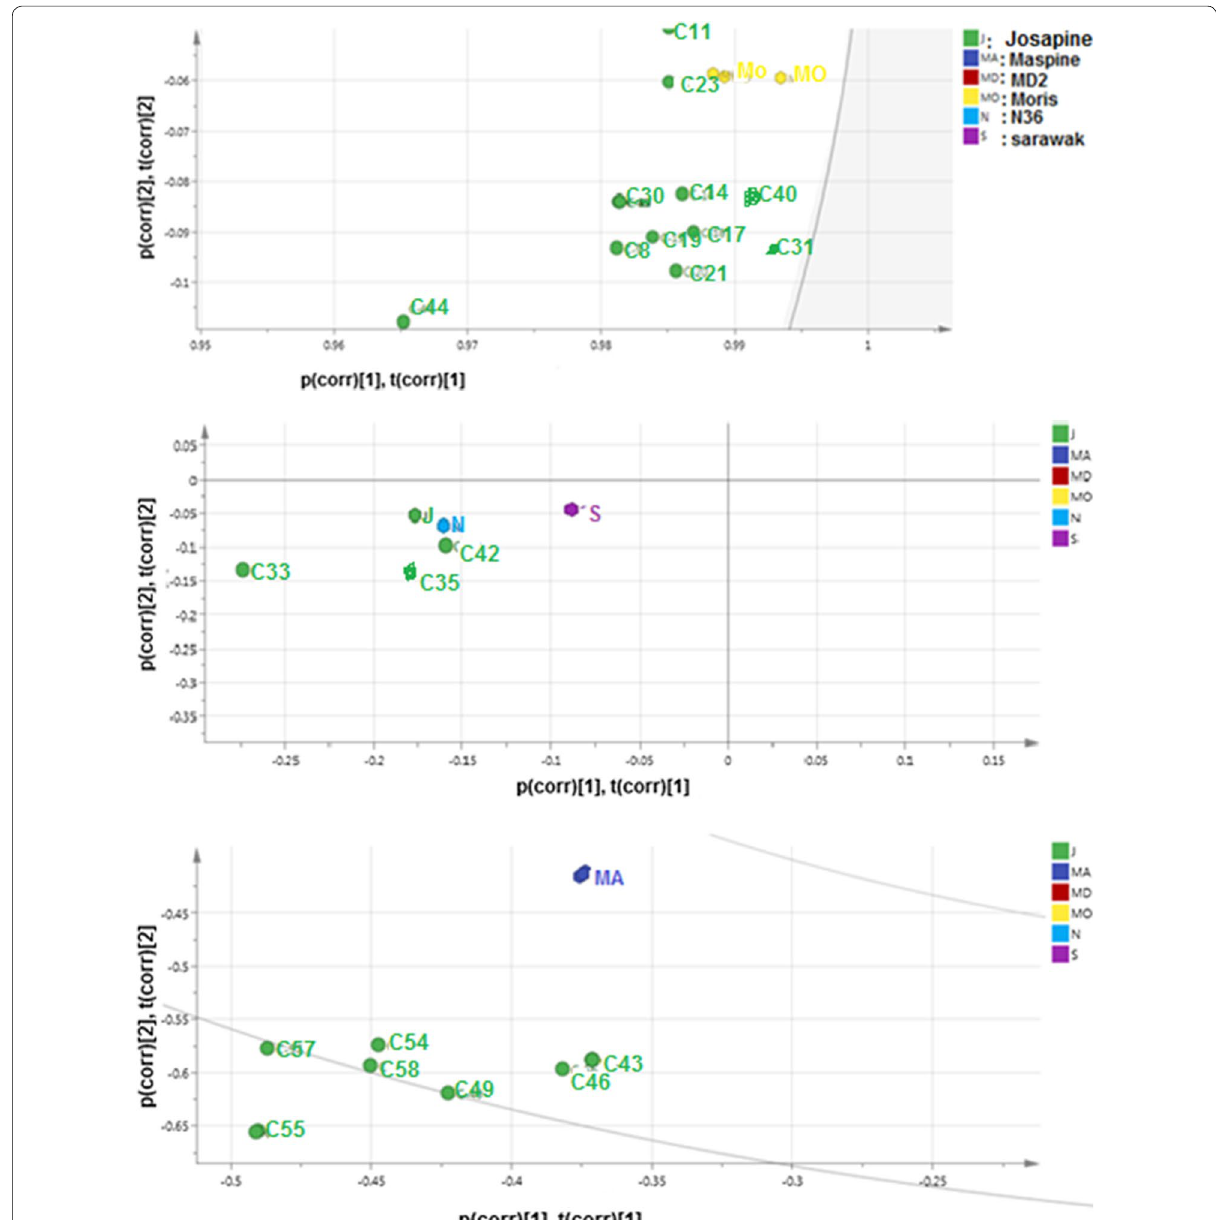
Fig. 2 Visualization of PLS weight plot of Fig. 1b. 1, 2 and 3 are aroma compounds correlating with Moris, (yellow), Sarawak, Josapine, N36 and Maspine